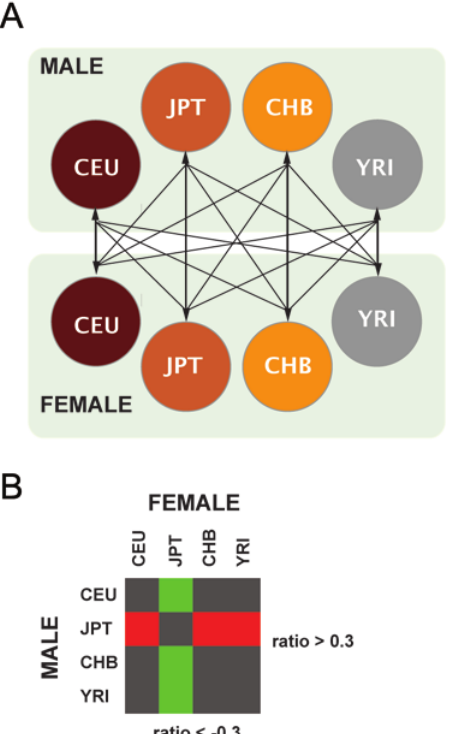
Figure 1. General Strategy Used in the Analysis of Copy Number Variants (CNVs) with Population-Specific frequency changes. (A) Pools of genomic DNA of 25 unrelated males and 25 females from the four HapMap populations were prepared and hybridized to the different array platforms. In total, sixteen inter- population CGH experiments were performed in each platform. The circular design of the hybridization pairs (panel A) allowed us to assign the most likely population to carry the variation, assuming the most parsimonious scenario. (B) This combination of hybridizations also allowed us to minimize the calling of CNVs on spurious positive signals. For instance, for a CNV to be called as a YRI-specific loss, the hybridizations of CEU, CHB and JPT male pools were required to show an increased hybridization signal with respect to the YRI female pool (log 2 ratio $ 0.3, green squares), the hybridization of the YRI male pool versus the rest of pools had to show decreased signals (log 2 ratio #2 0.3, red squares), and the rest of combinations should show values around 0 and not above the |0.3| threshold (dark squares).